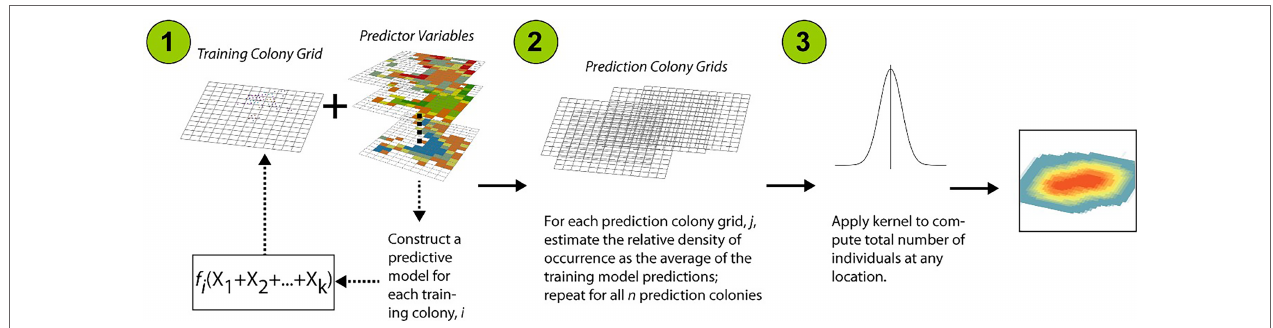
FIGURE 2 | Flowchart illustrating the procedure for statistical modelling: (1) using training colonies, construct colony-specific, Boosted Regression Tree (BRT) models, (2) average the predictions derived from each colony-specific model, for each prediction colony grid, and (3) apply a kernel density smoother to the immediate nearest neighbours, defined using a radius equal to the diagonal distance of the prediction grid cell, to compute the total number of individuals at any